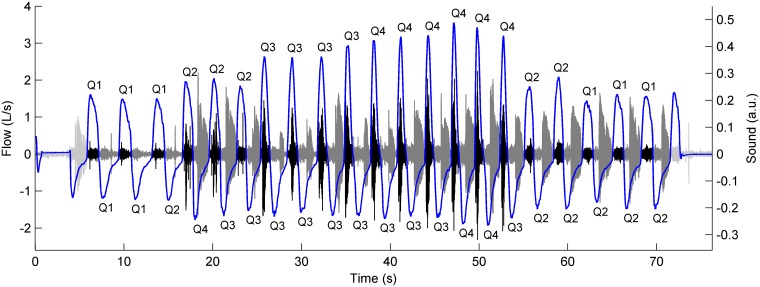
Respiratory sounds and flows recorded during the performance of a progressive maneuver at baseline.Segmented respiratory phases are highlighted in black (inspiration) and dark grey (expiration). Q1-Q4 labels indicate the flow quartile assigned to each respiratory phase.